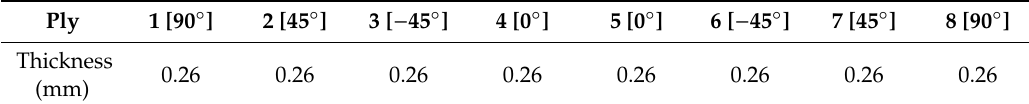
Figure 6. The fiber orientation definition of the web and flanges. 2.4. Material Properties Model The material model of the GFRP strut, which was performed in ABAQUS ® , was based on the assumption used in the previous study of Debski et al. [23]. The mass density of the GFRP material was 2200 (kg/m 3 ). The strength properties of the GFRP strut are presented in Table 2. Table 2. Material Properties of the GFRP Strut Used for the Simulation. 1 E (MPa)